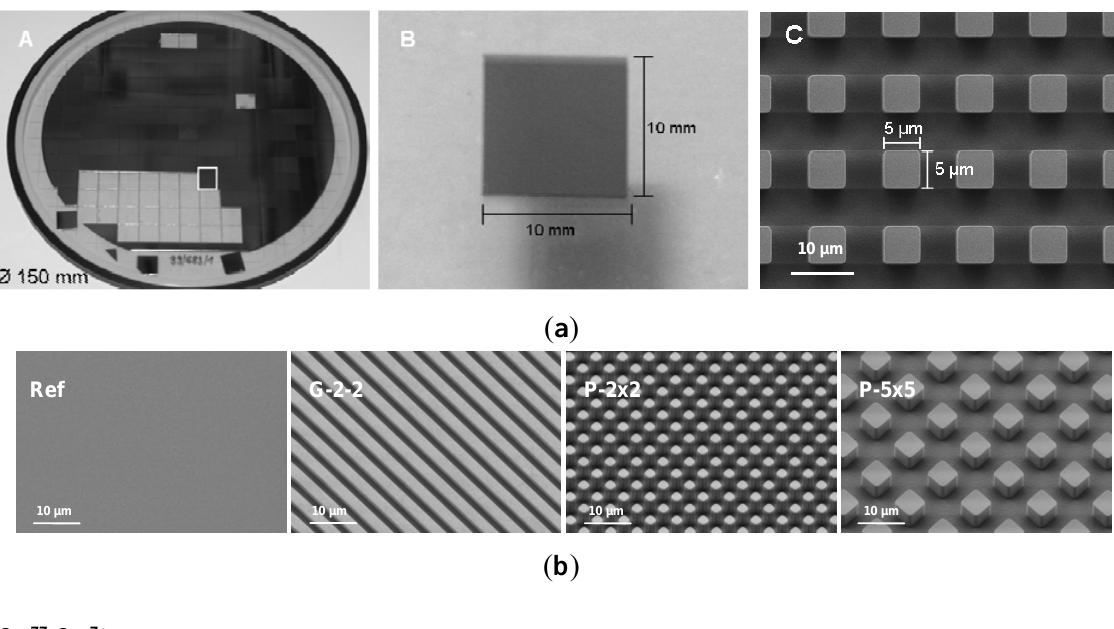
Figure 1. ( a ) Size and dimension of fabricated samples. (A) wafer Ø150 mm with arrays 10x10 mm, (B) single array 10 × 10 mm and (C) FE-SEM image of Ti-coated periodical cubic pillar array with the dimension 5 × 5 × 5 µm (P-5×5) (FE-SEM Supra 25, Carl Zeiss, bar = 10 µm). ( b ) FE-SEM images of Ti-coated periodical arrays on silicon substrate with regular geometry: planar titanium reference (Ref), rectangular grooved array of 2 µm width and 2 µm height (G-2-2), cubic pillar arrays with the dimensions 2 × 2 × 5 µm (P-2×2)